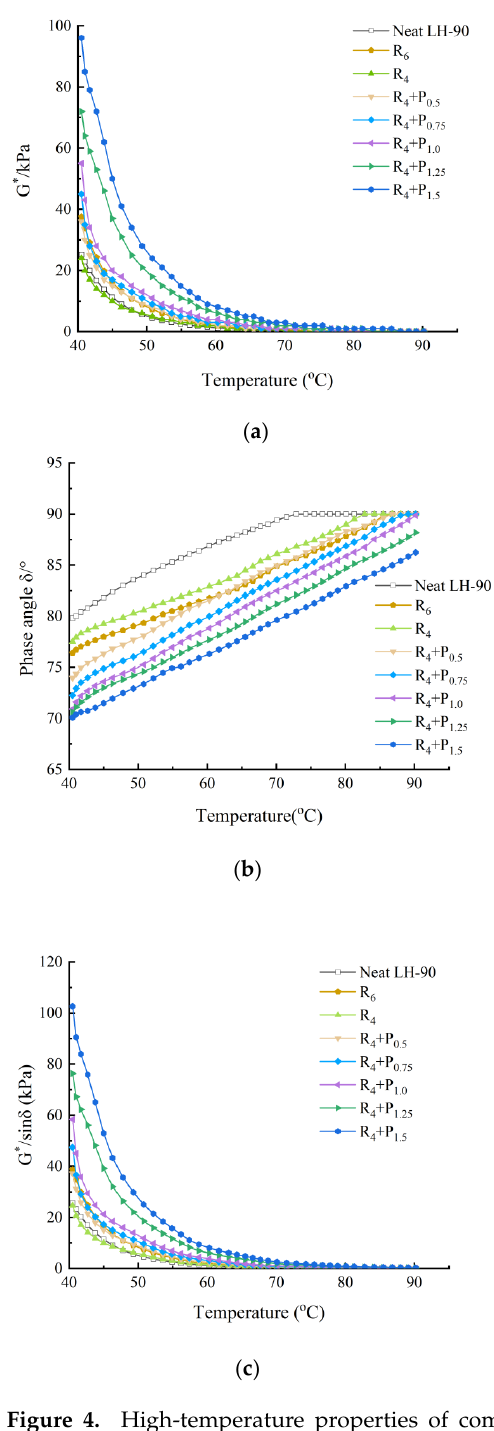
Figure 4. High-temperature properties of compound ratio of PPA – SBR and LH – 90# neat asphalt: ( a ) Complex modulus-temperature results; ( b ) Phase angle-temperature results; ( c ) G*/sinδ -tenperature results.